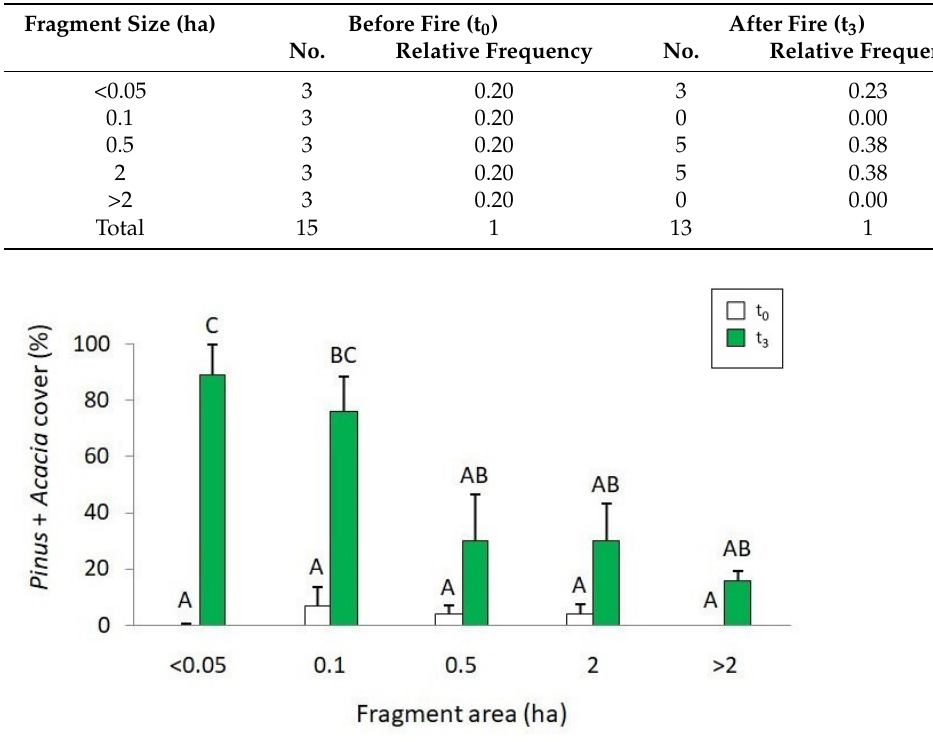
Figure 3. Changes in ( a ) average area of grassland fragments, and ( b ) average distance between grassland fragments before (t 0 , white) and after (t 3 , green) the fire. Red arrow on the x ‐ axis indicates the occurrence of the fire. Table 2. Comparison of the relative frequency of grassland fragments of different area at different times in relation to fire (t 0 and t 3 ; before and after, respectively). Adapted from Yezzi, Nebbia and Zalba (2020).